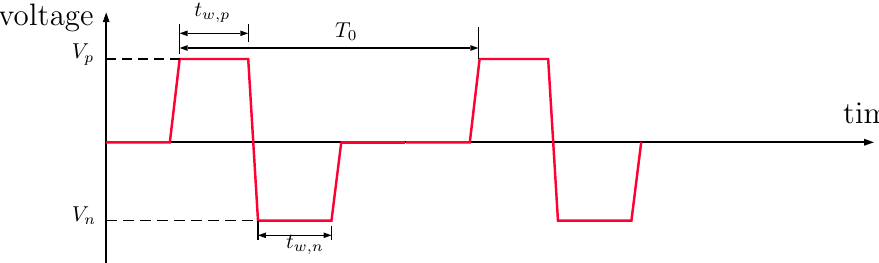
Figure 11. A general square pulse shape for controlling droplet generation with RC1536. The pulse includes negative and positive applied voltage ( V n , V p ), pulse width ( t w , n , t w , p ), and a period T 0 .